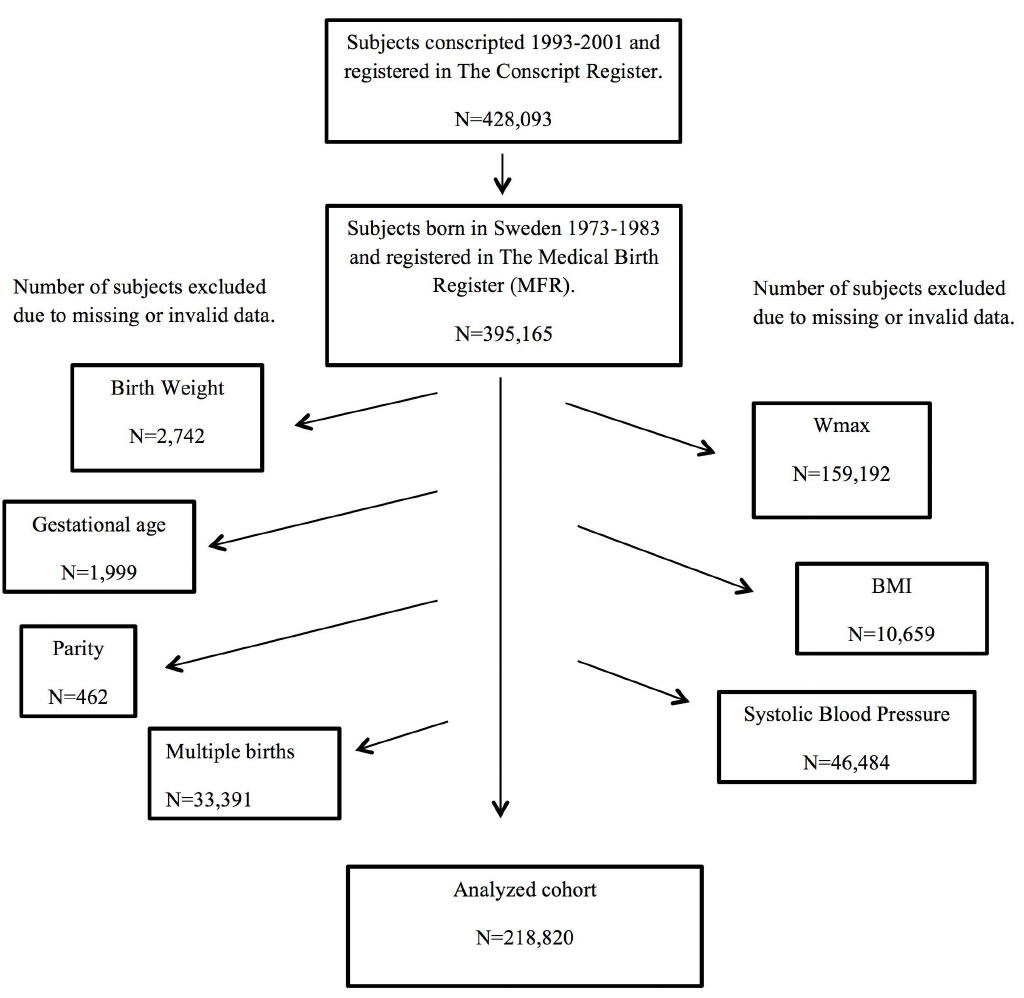
Figure 1. Formation of analyzed cohort. One subject may have missing data in more than one category. W max =maximal exercise capacity, BMI=Body Mass Index.